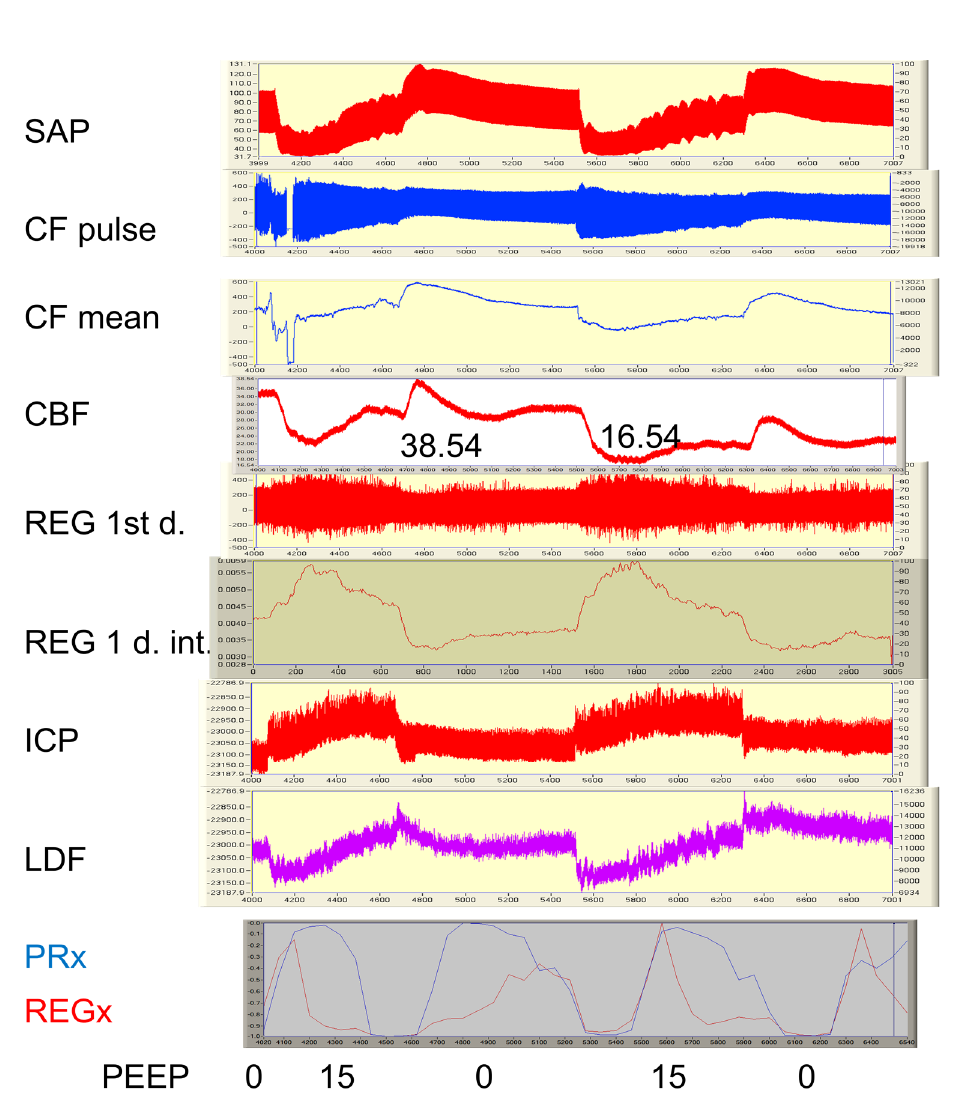
Fig. 1: Effect of 15 water cm PEEP. According to the CBF AR definition, here CBF AR is active and reflected by CF pulse amplitude, REG 1st derivative, its integral and ICP. CBF AR is passive in traces CF mean, LDF and CBF (quantitative CBF; unit ml/100gr/min). Both calculated CBF AR indexes (PRx from ICP and REGx from REG) show active (-1) status at the same time. Legend: SAP: systemic arterial pressure; CF pulse: carotid flow pulse; CF mean: mean CF; CBF: absolute blood flow (ml/100 g/min), numbers indicating maximum and minimum values; REG 1st d.: REG first derivative; REG 1st d. int: integral of REG 1st derivative; ICP: intracranial pressure; LDF: laser Doppler flow (brain). PRx: Person's correlation coefficient calculated from SAP and ICP; REGx: Person's correlation coefficient calculated from SAP and REG. PEEP units are in water cm. Pig ID: CBF 13, file 13:53; time window 4000-7007